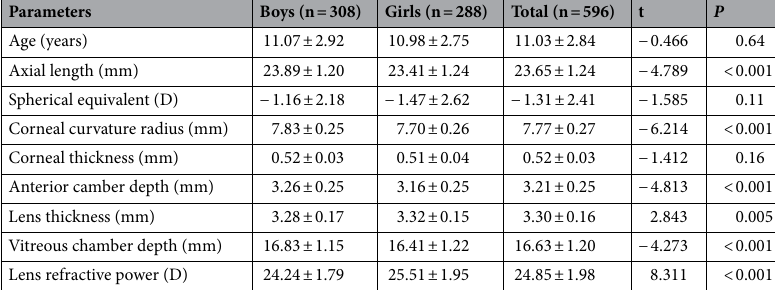
Table 1. General characteristics of the study participants stratified by sex.